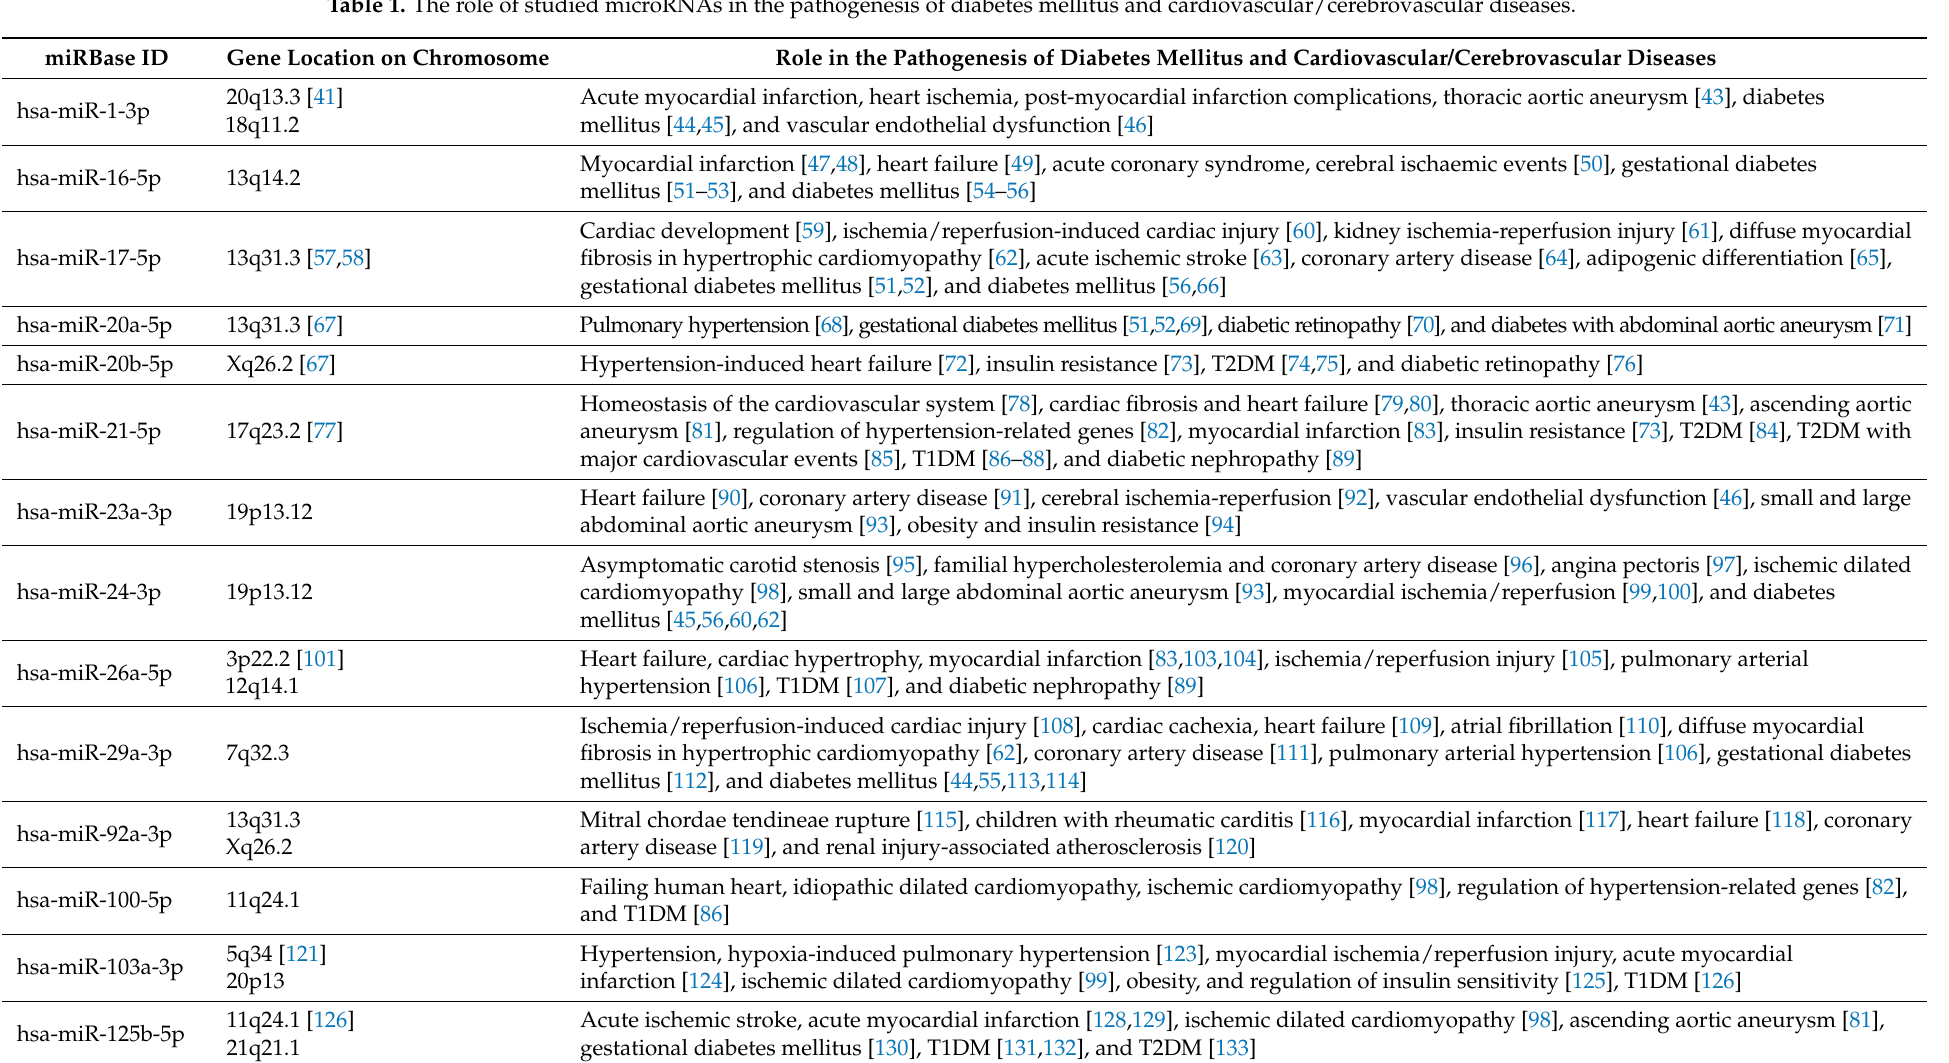
Table 1. The role of studied microRNAs in the pathogenesis of diabetes mellitus and cardiovascular/cerebrovascular diseases. miRBase